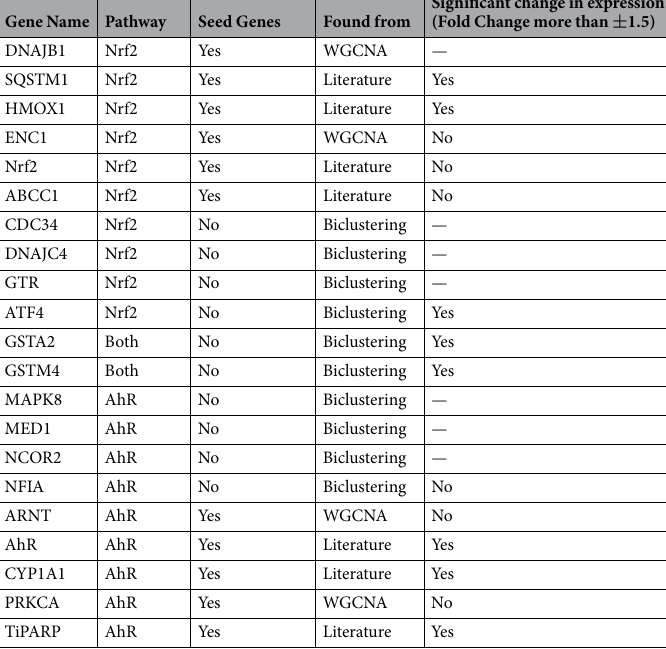
Table 3. Expression changes upon coffee exposure of genes selected using the biclustering algorithm. ‘—’ Indicates genes that were not the target of experimental validation. Genes were considered to be responsive if they were differentially expressed in at least two coffee samples.